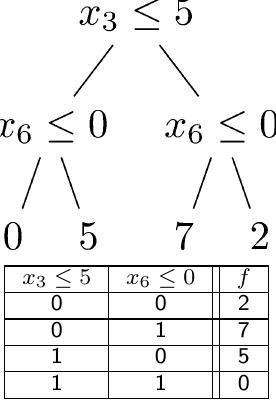
Table 1 Oblivious Decision Tree example from Lou and Obukhov demonstrating a Decision Tree and Decision Table that provide equivalent logic